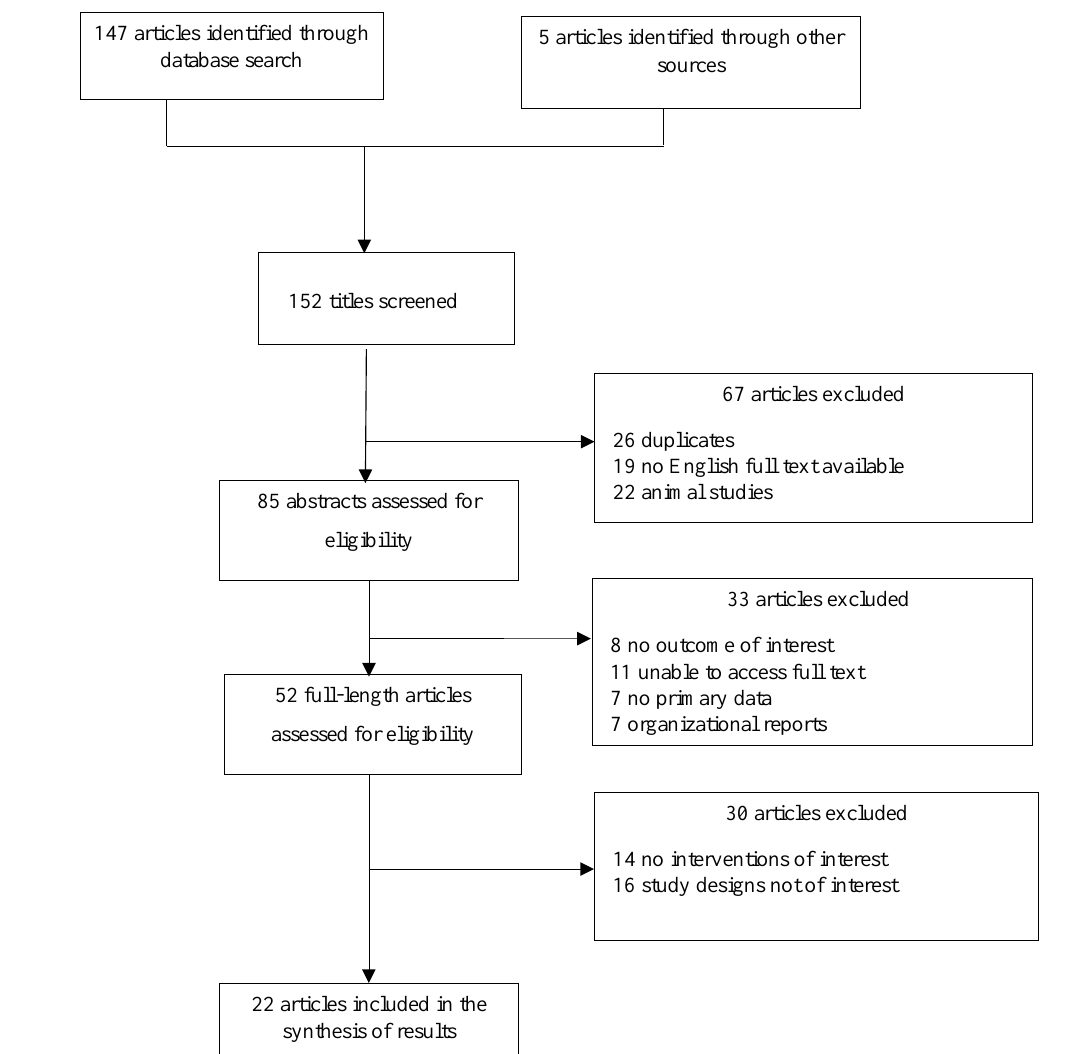
Figure 1. PRISMA flowchart of the search strategy, inclusion and exclusion screening, and accepted studies of the review of changes in the incidence of respiratory viral infections during the COVID-19 pandemic